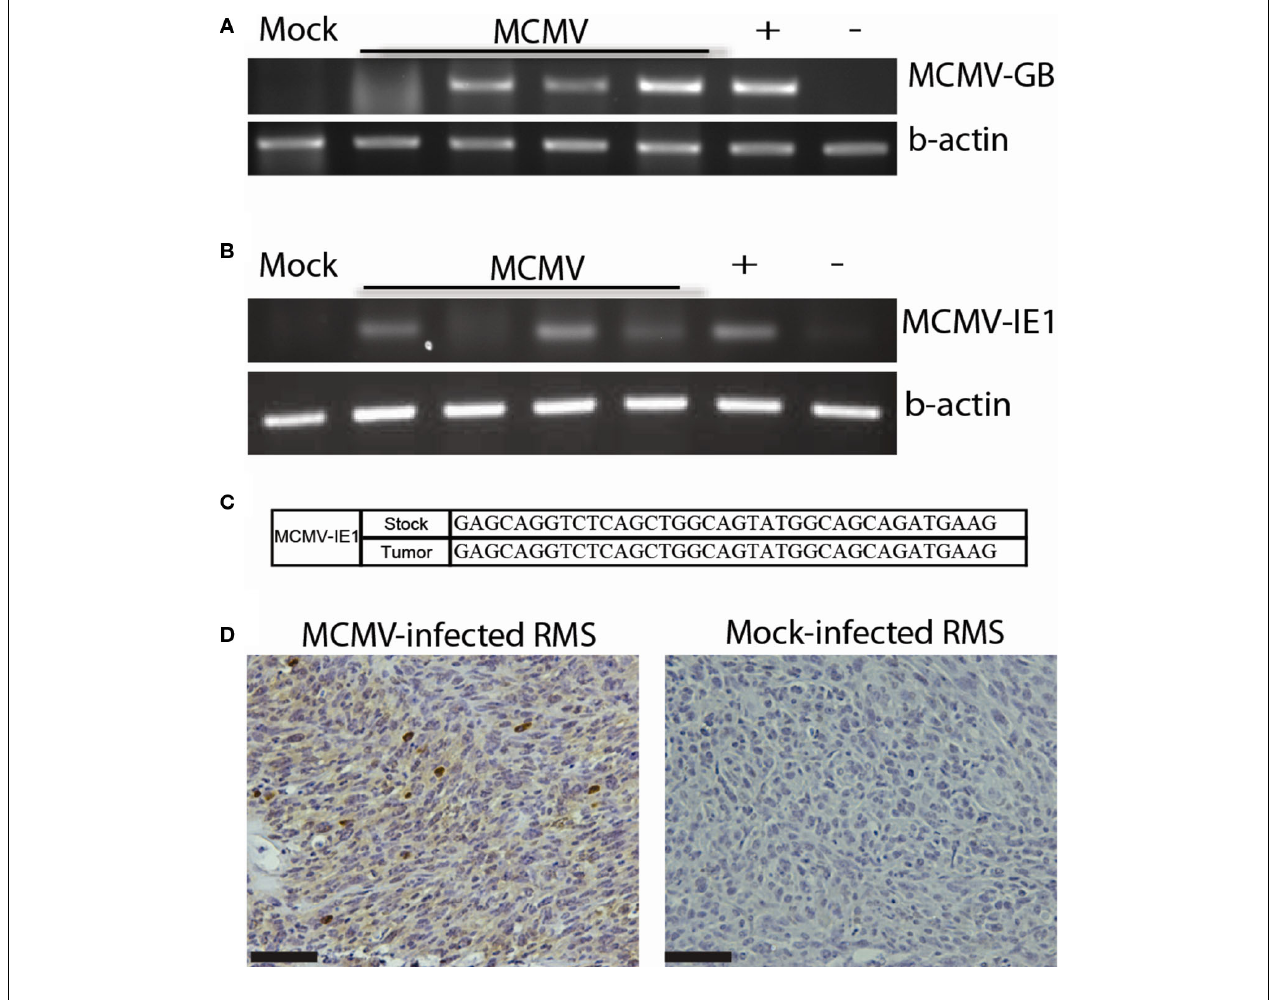
FIGURE 3 | MCMV analysis of mouse tumors . (A) PCR for MCMV DNA in tumors from MCMV ( n = 4) and mock-infected ( n = 1) mice. (B) RT-PCR for MCMV-IE1 in tumors from MCMV ( n = 4) and mock-infected ( n = 1) mice. (C) RT-PCR product fidelity was validated